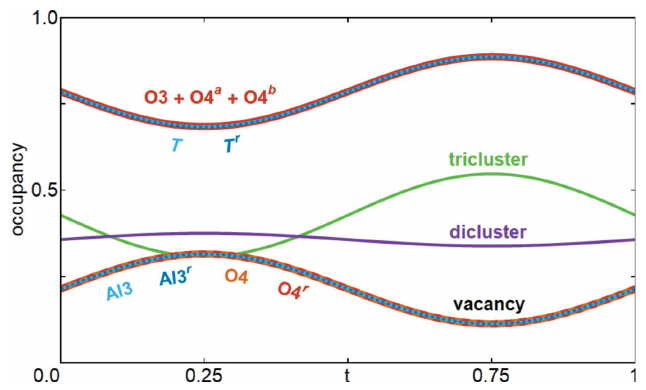
Figure 4 Occupational modulation functions of selected atomic domains. Site labels can be compared with Fig. 3. The curves of T , T r and (O3 + O4 a + O4 b ) are identical. The same holds for the curves of Al3, Al3 r , O4 and O4 r , which are described in the text. The curves labelled tricluster, dicluster and vacancy sum up to a value of 1 and represent the respective 1 fractions occupying the space around (0 1 2 2